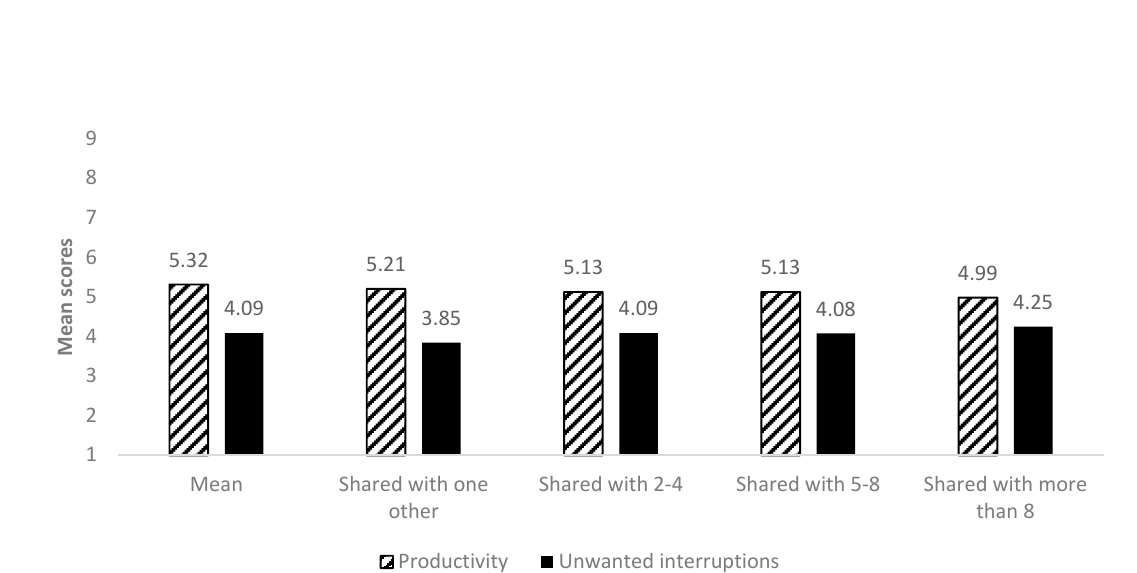
Figure 6. Comparative analysis of mean scores of productivity and unwanted interruptions among various workgroups. Table 16. Descriptive statistics of productivity and unwanted interruptions for different workgroups.